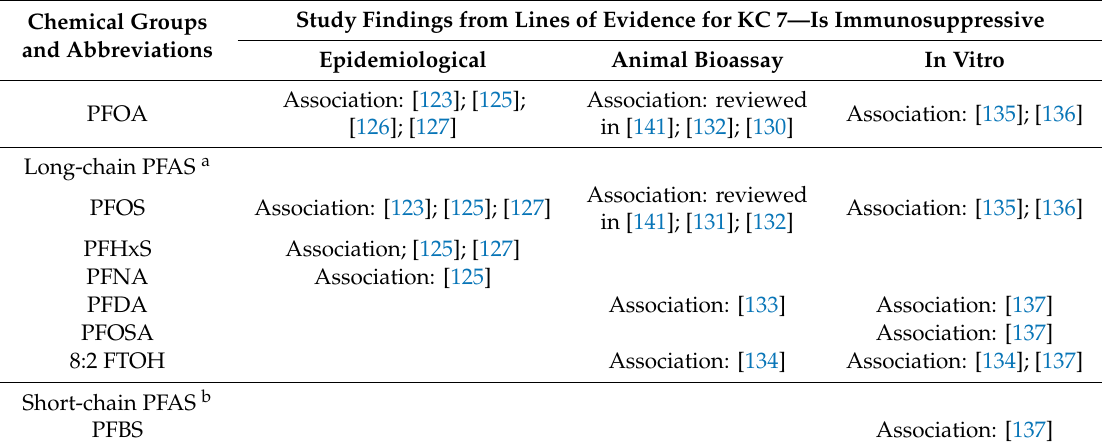
Table 6. Chemical specific study findings for key characteristic seven—is